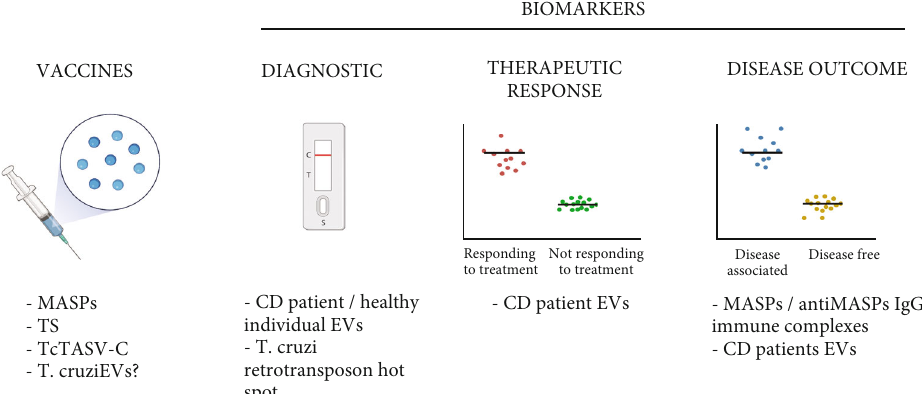
Figure 3: Potential role of EVs as new tools for CD prevention and control. EVs from T. cruzi or parasite proteins found in the EVs have been tested as vaccine antigens for Chagas disease. EVs isolated from CD patients, the retrotransposon hot spot T. cruzi protein, and the immunocomplexes found in CD patients are also being studied for their potential as biomarkers for diagnosis, therapeutic response, and disease outcome (created with